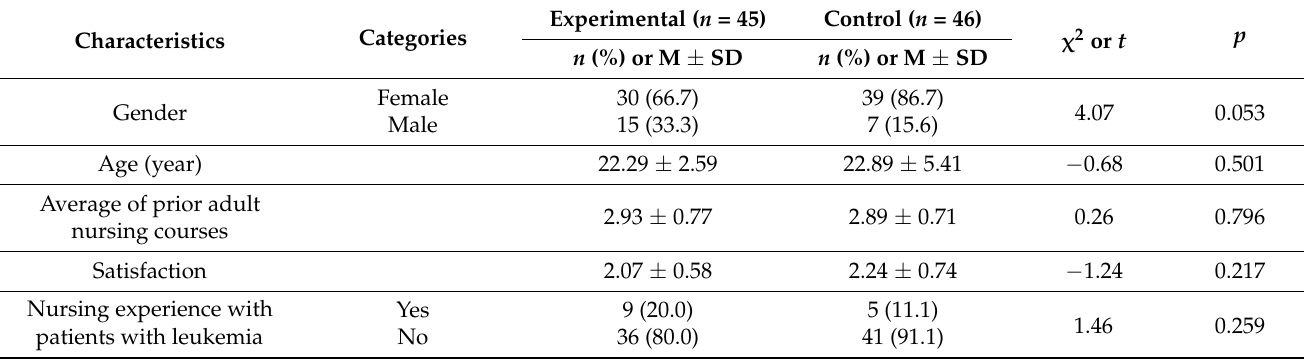
Table 2. General characteristics and homogeneity of experimental and control groups ( n = 91).